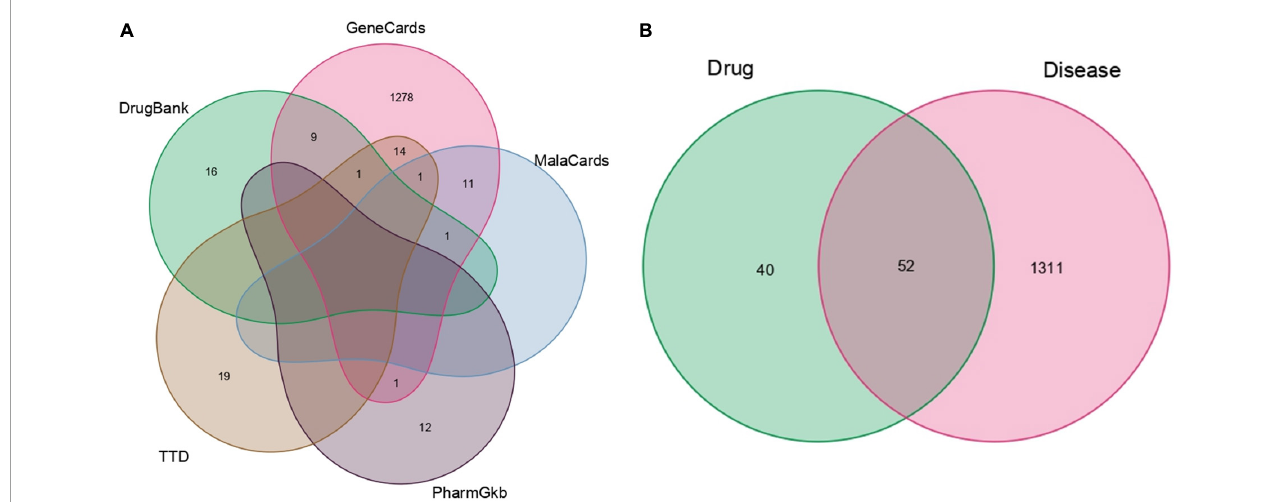
FIGURE2 Venn diagrams. (A) AS-related genes. (B) THD targets and AS targets.